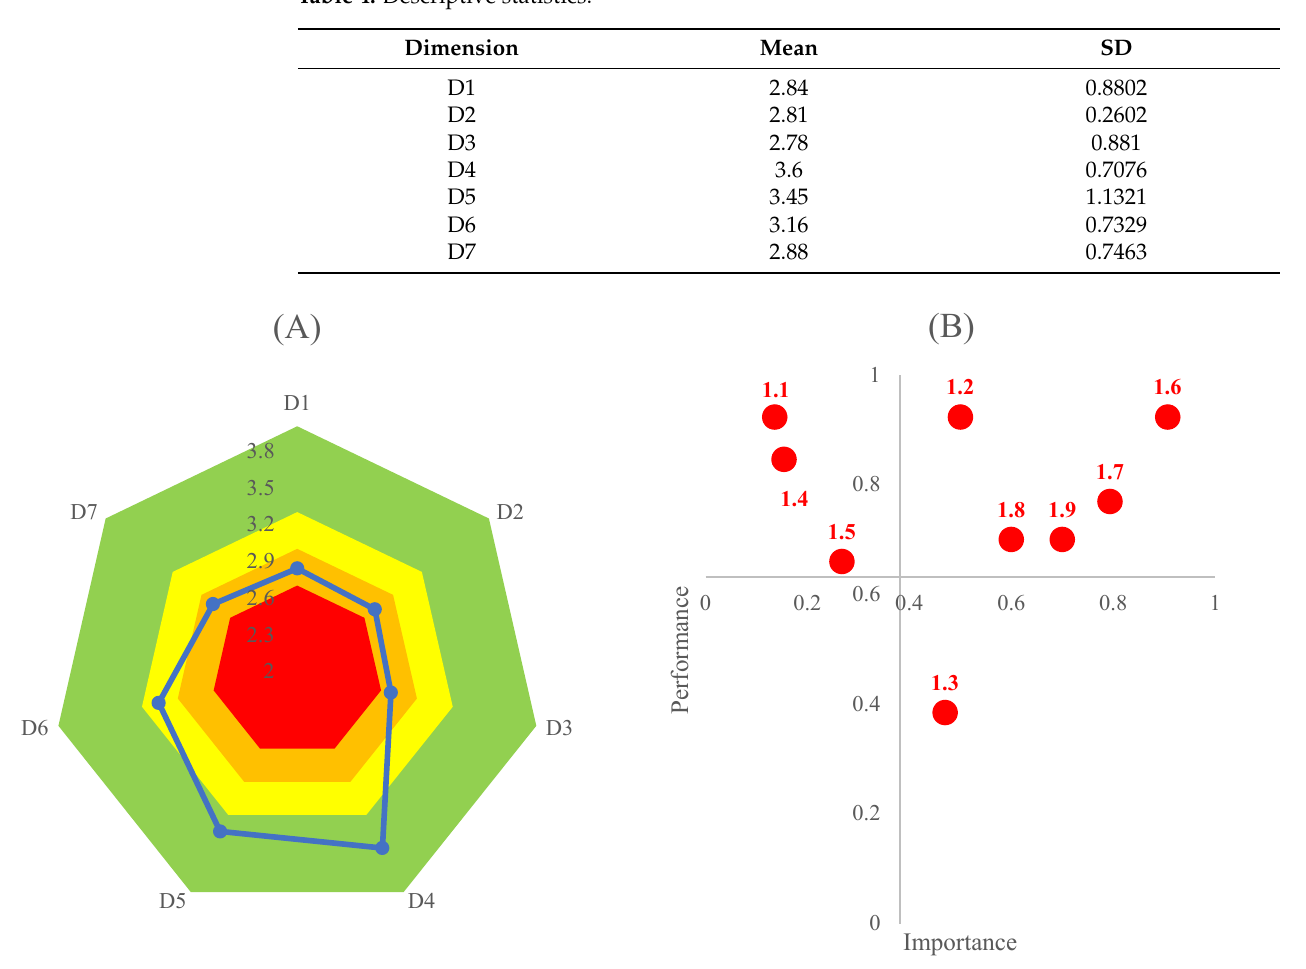
Table 4. Descriptive statistics.